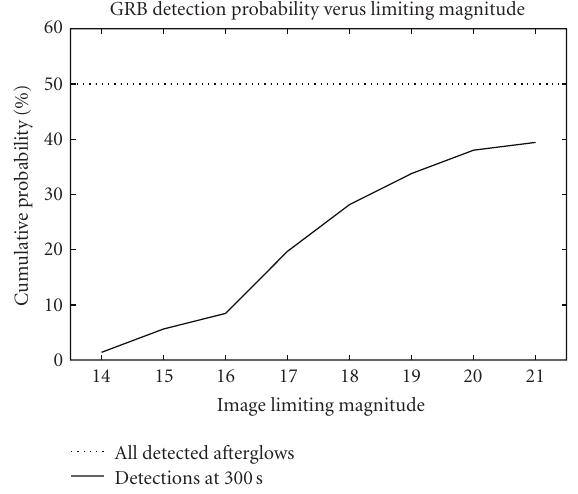
Figure 4: The graph (based on T 300 data from Table 3) showing the likelihood of detection of an optical afterglow of a GRB as a function of the magnitude the telescope can detect (in the time interval discussed here). The dotted line delimits 50%—the ratio of GRBs in our data for which there was eventually discovered an optical